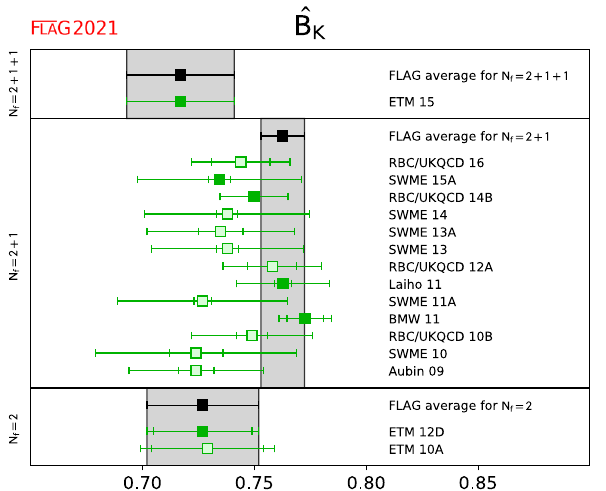
Fig. 20 Recent unquenched lattice results for the RGI B -parameter ˆ B K . The grey bands indicate our global averages described in the text. For N f = 2 + 1 + 1 and N f = 2 the global averages coincide with the results by ETM 15 and ETM 12D,